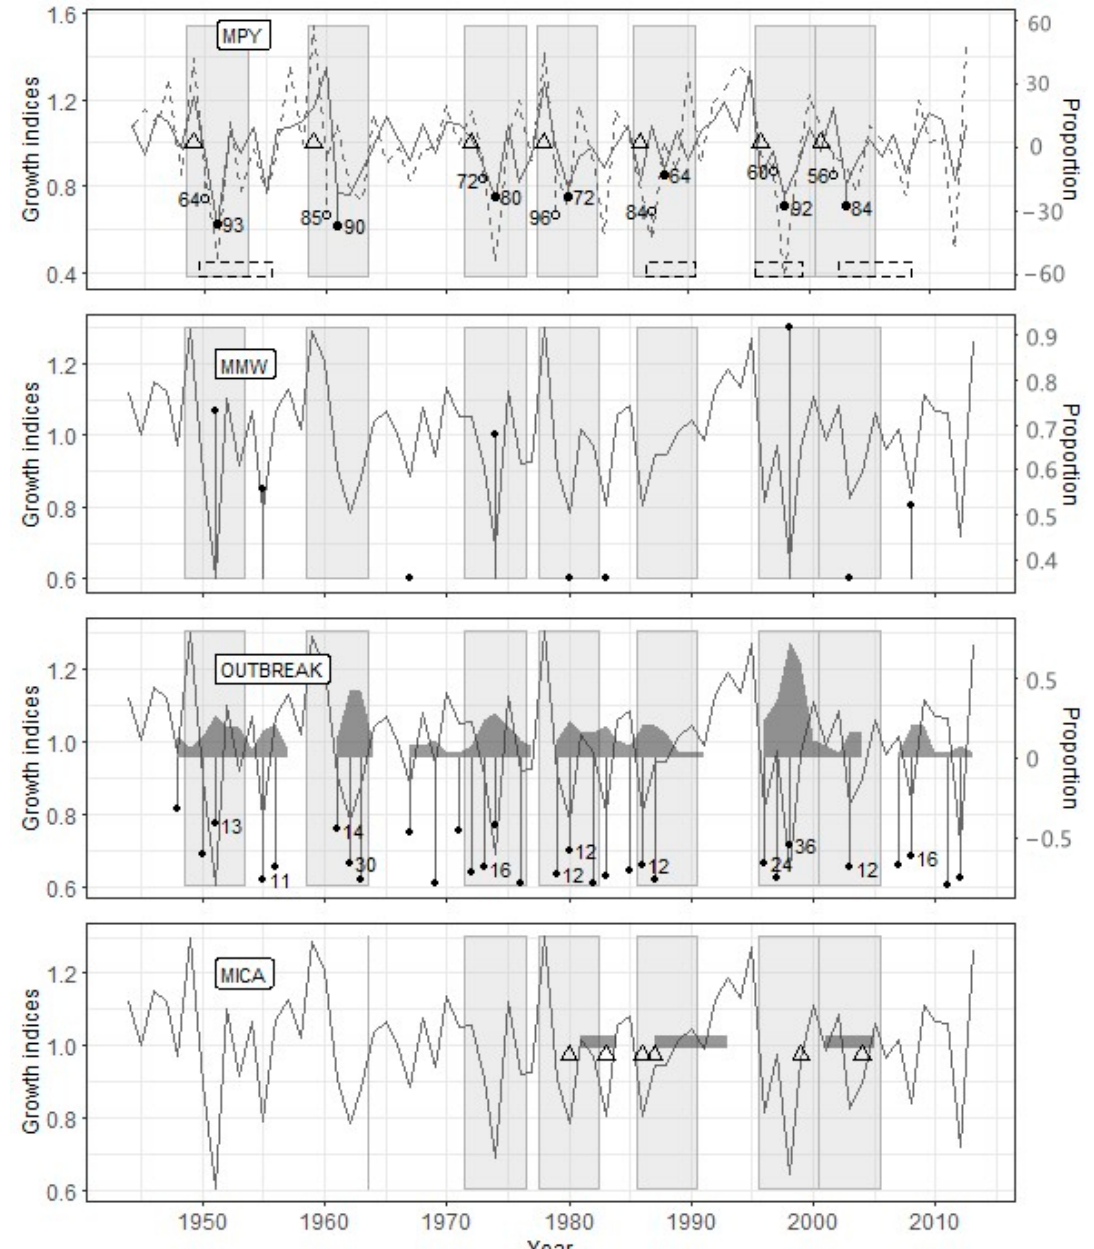
Figure 3. Reconstruction results for the Zarech’e site. PYM: earlywood radial growth index—solid line, latewood radial growth index—dashed line, defoliation year—triangle, change.l —open circles (number— sync.l ), change.e —filled circles (number— sync.e ), periods of documented outbreaks—dashed rectangles. MWM (moving window method): perc —filled circles. OUTBREAK: radial growth index decline—filled circles (number—the proportion of trees (%) with radial growth index decline below the threshold), the proportion of trees with a decline in growth ≥ perc —grey polygon. MICA: year of assumed defoliation—triangle, the period of a decrease in the values of the selected components below the threshold—dark grey rectangle; to the vertical line’s right is the analyzed time interval. The solid line for MWM, OUTBREAK, and MICA (method of independent component analysis) indicates the radial growth index curve. Light grey rectangles for all graphs indicate the periods of the assumed effect of defoliation on radial growth .